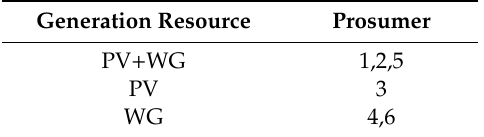
Table 1. The type of generation resource of each prosumer.